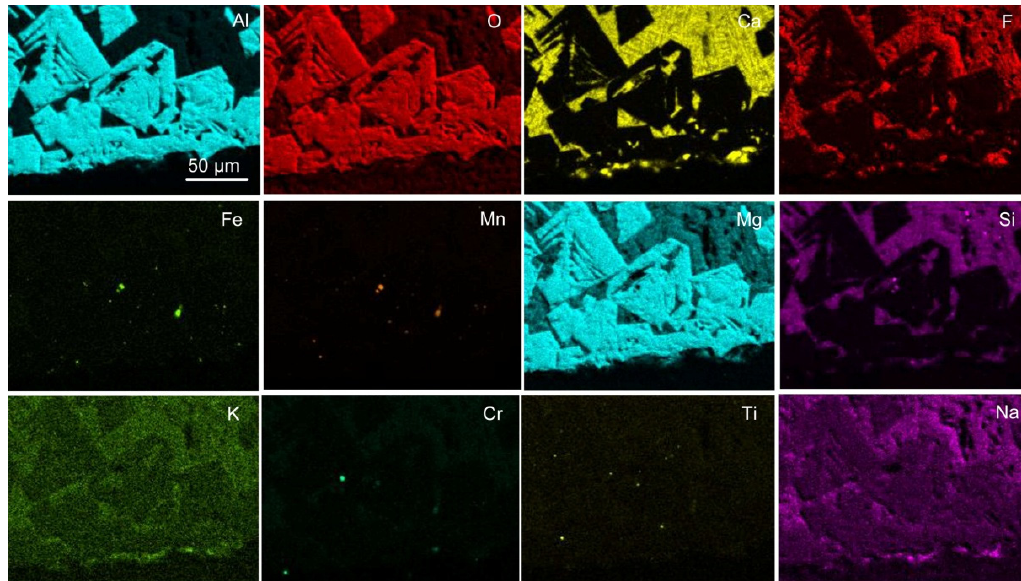
Figure 14. EDX map sample area in Figure 13a: MP2 slag sample.